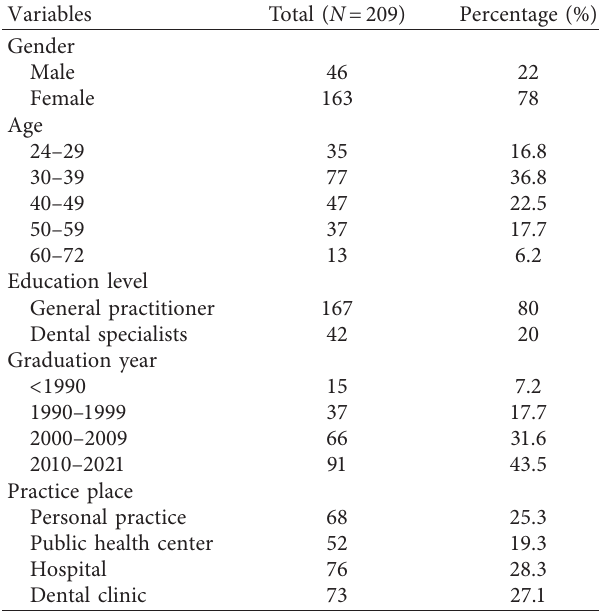
Table 1: Characteristic of respondents.